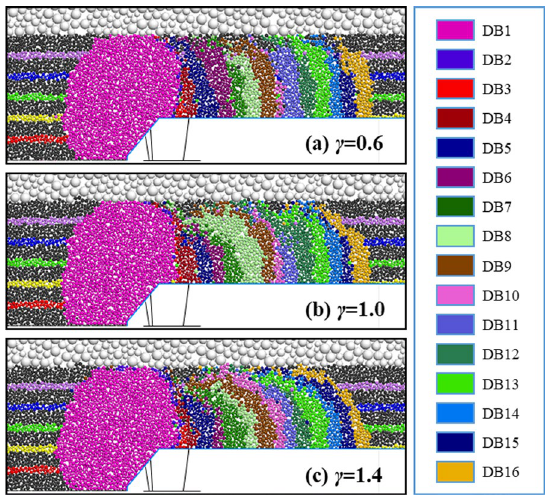
Fig. 9 Variation of W s in the original model: a Width of a sickle-shaped drawing body; b Variation of